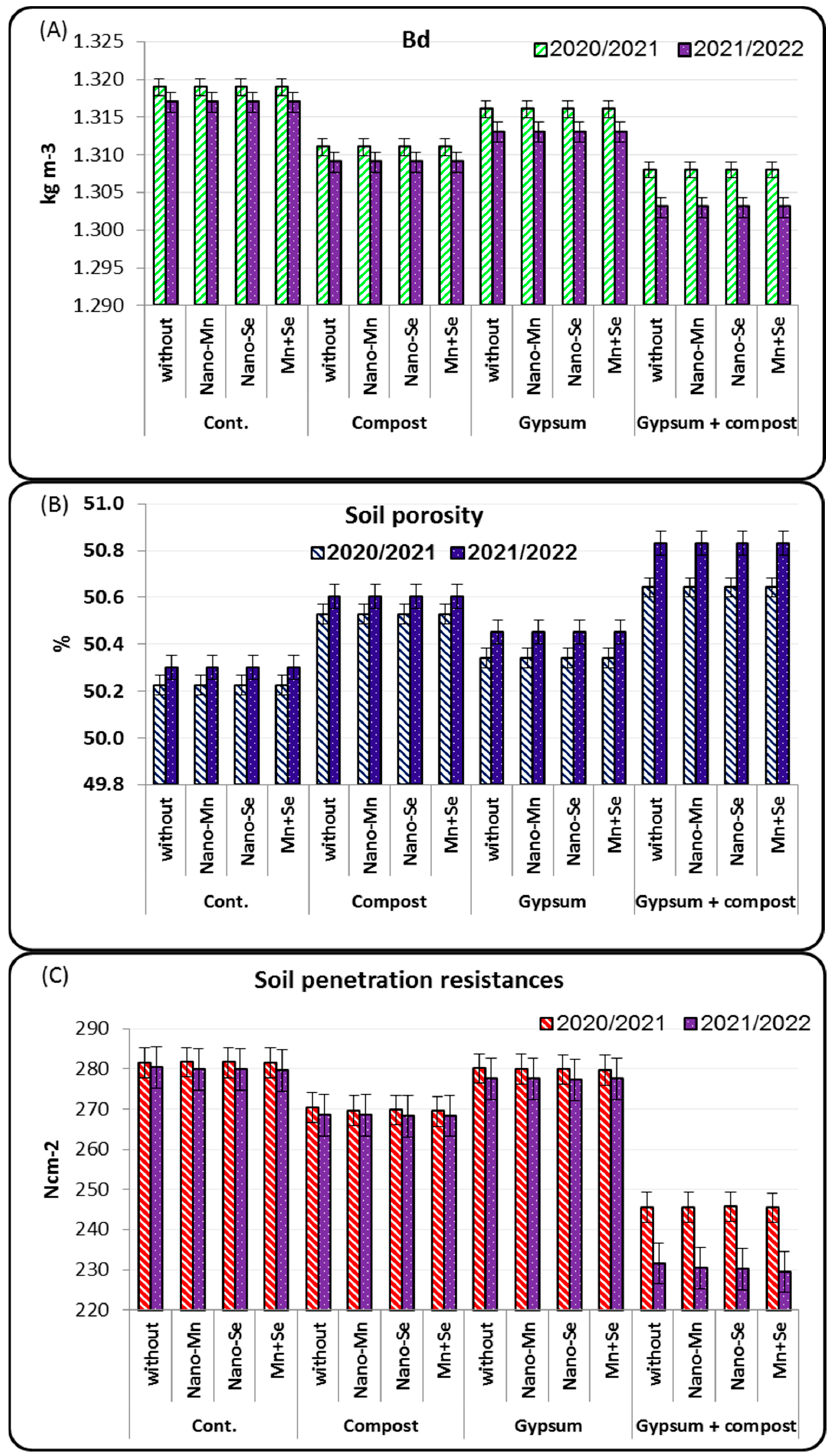
Figure 1. Effect of compost, gypsum, and foliar application of some nanoparticles on soil bulk density ( A ), soil porosity ( B ), and soil penetration resistance (SPRa) ( C ) in the 2020/2021 and 2021/2022 seasons. The values are for soil collected at depths of 0–20, 20–40, and 40–60 cm.